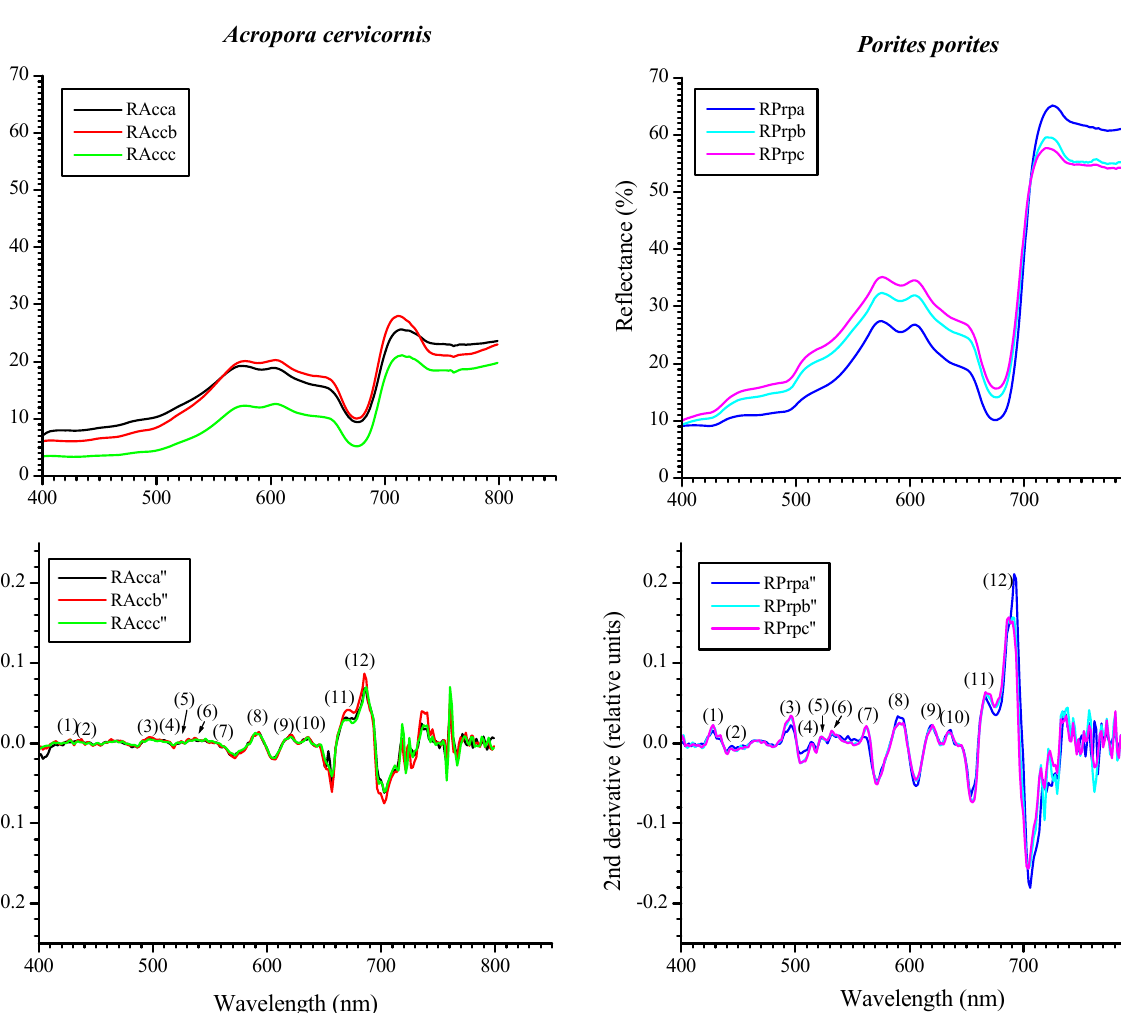
Figure 5. Reflectance curves as measured from three locations of a branch (individual) of each studied species. The 2nd derivatives of each curve within a sample of each species show minimal intra-specimen variation of the spectral features independently of the difference in magnitudes in reflectance along a single branch. The numbers in parenthesis in the derivative graphs represent peaks at specific wavelengths (nm): (1) 427, (2) 442, (3) 495, (4), 514, (5) 522, (6) 530, (7) 563, (8) 589, (9) 618, (10) 634, (11) 665 and (12)